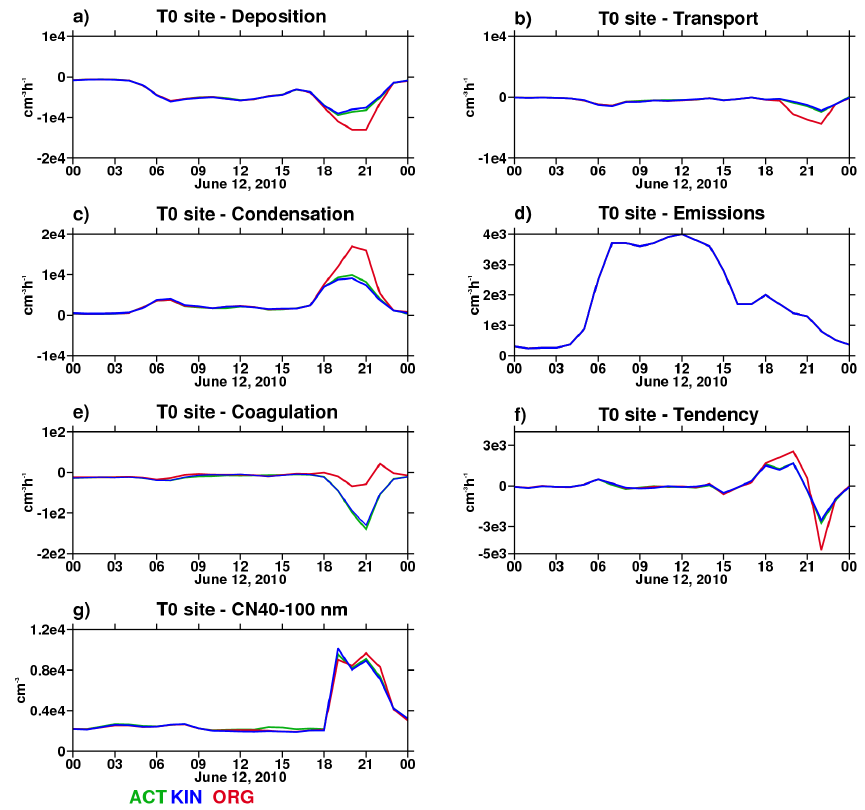
Figure 17. Budget diagnostic terms for 40–100nm particles at the T0 site on 12 June: (a) deposition; (b) transport; (c) condensation; (d) emissions; (e) coagulation; (f) total tendency; and (g) particle number